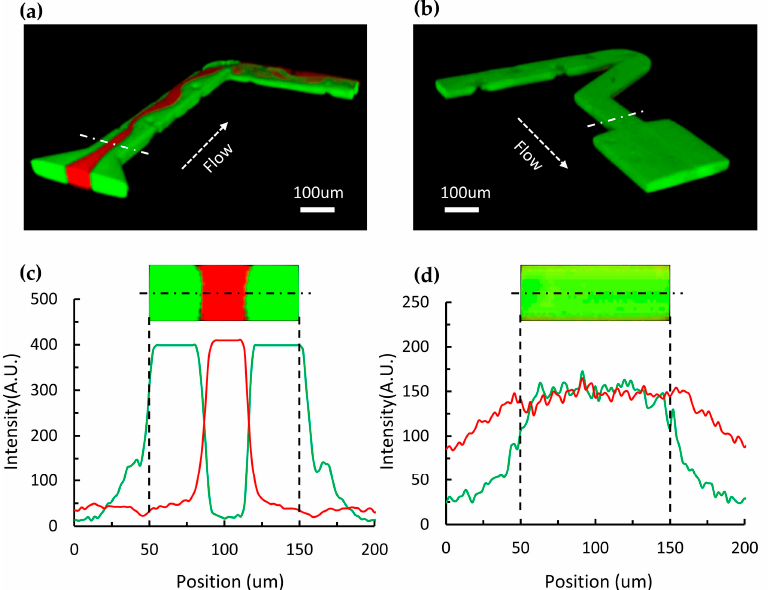
Figure 2. Mixing process of regent flows in microchannel. ( a – b ) Images of the three-dimensional liquids distributions capture by laser scanning confocal microscopy before and after the mixing process. The flow rates are fixed at 20 µL/min for each reagent inlet. ( c – d ) Cross-sectional liquids distribution corresponding to ( a – b ).